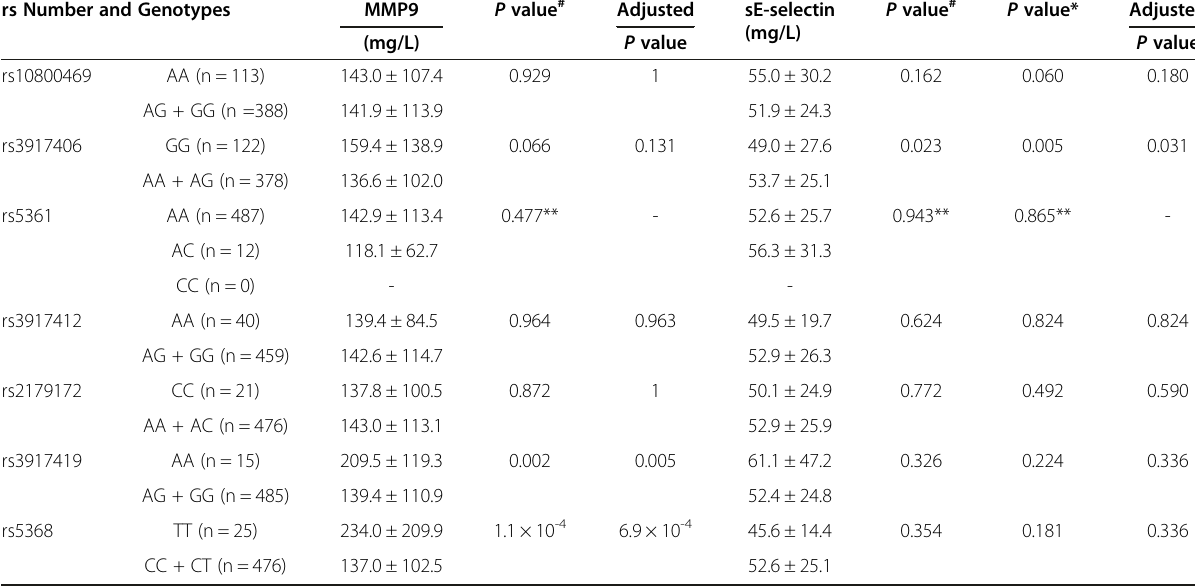
Table 2 Serum MMP9 and sE-selectin levels by SELE genotype in recessive model rs Number and